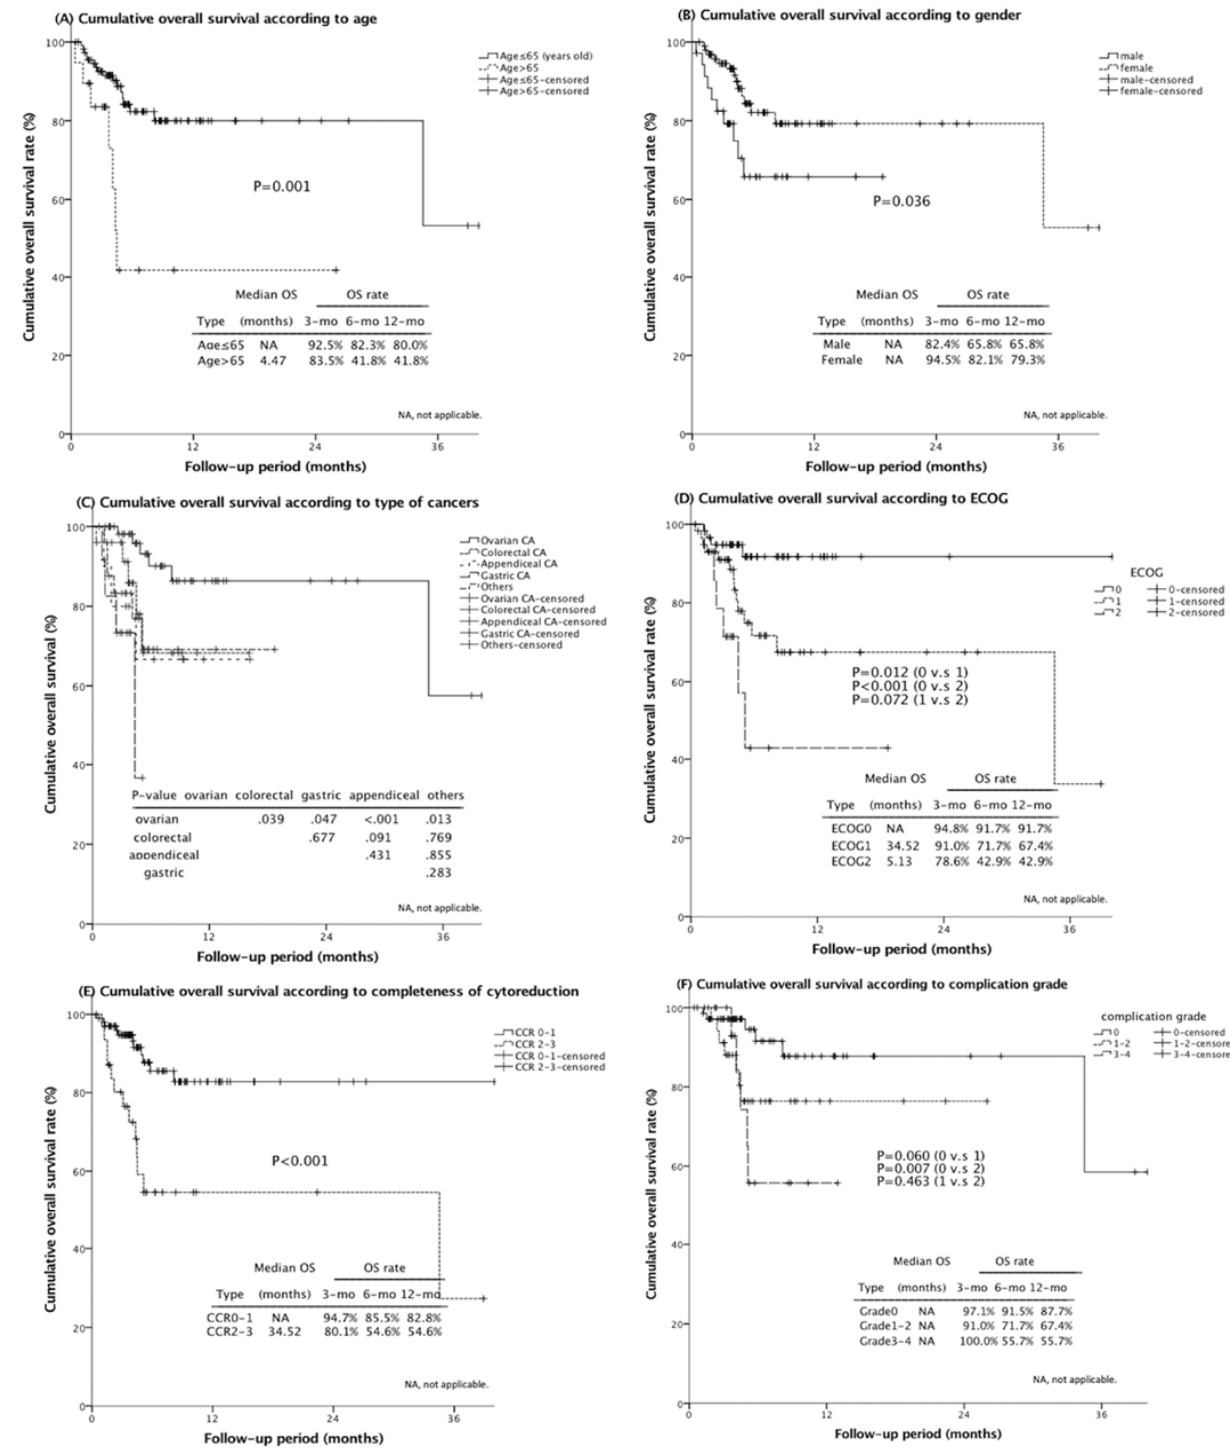
Figure 1. Kaplan–Meier plots of overall survival according to different subgroups. ( A ) Patients with older age (>65-year- old) demonstrated poor outcomes ( p value = 0.001). ( B ) Female gender seemed to have a superior survival outcome ( p value=0.036). ( C ) A more favorable outcome after CRS–HIPEC procedure was deliberated in patients with ovarian cancer than other malignancies ( p value, ovarian vs. colorectal: 0.039; ovarian vs. appendiceal: 0.007; ovarian vs. gastric: <0.001; ovarian vs. other cancers: 0.013). ( D ) As the ECOG increases, the corresponding survival seemed to decrease ( p value, ECOG 0 vs. ECOG 1: 0.012; ECOG 0 vs. ECOG 2: <0.001; ECOG 1 vs. ECOG 2: 0.072). ( E ) Patients achieved CCR 0-1 had better one-year OS than who did not (82.8% vs. 54.6%, p value < 0.001). ( F ) The presence of major postoperative complication was associated with a worse OS (absence vs. minor grade, p value = 0.060; absence vs. major grade, p value =